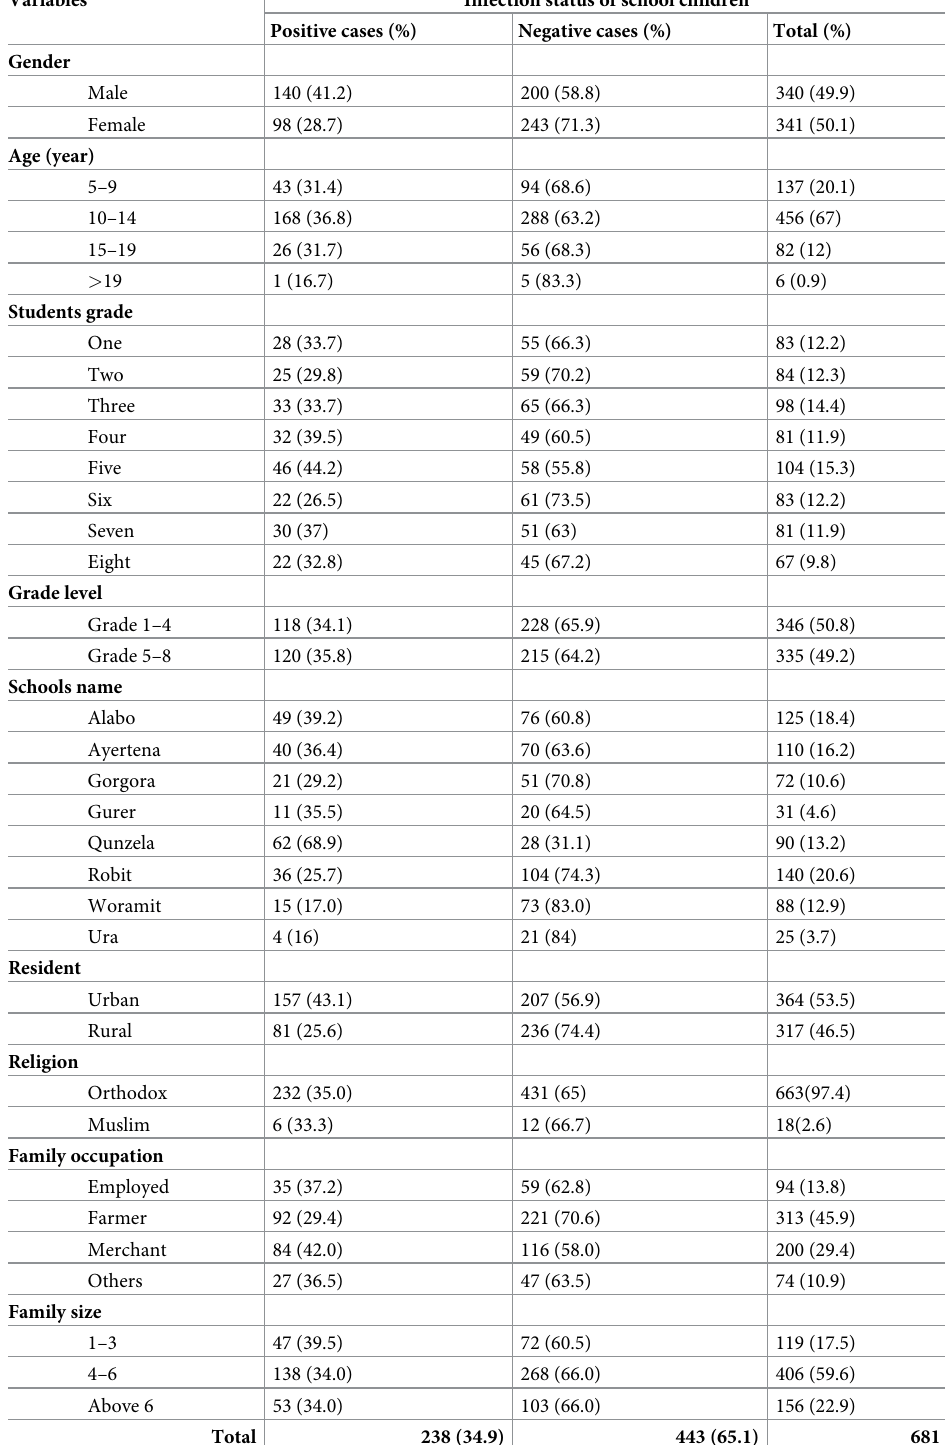
Table 1. Schistosoma mansoni infections across socio-demographic factors among schoolchildren attending in selected primary schools around Lake Tana, northwest, Ethiopia,